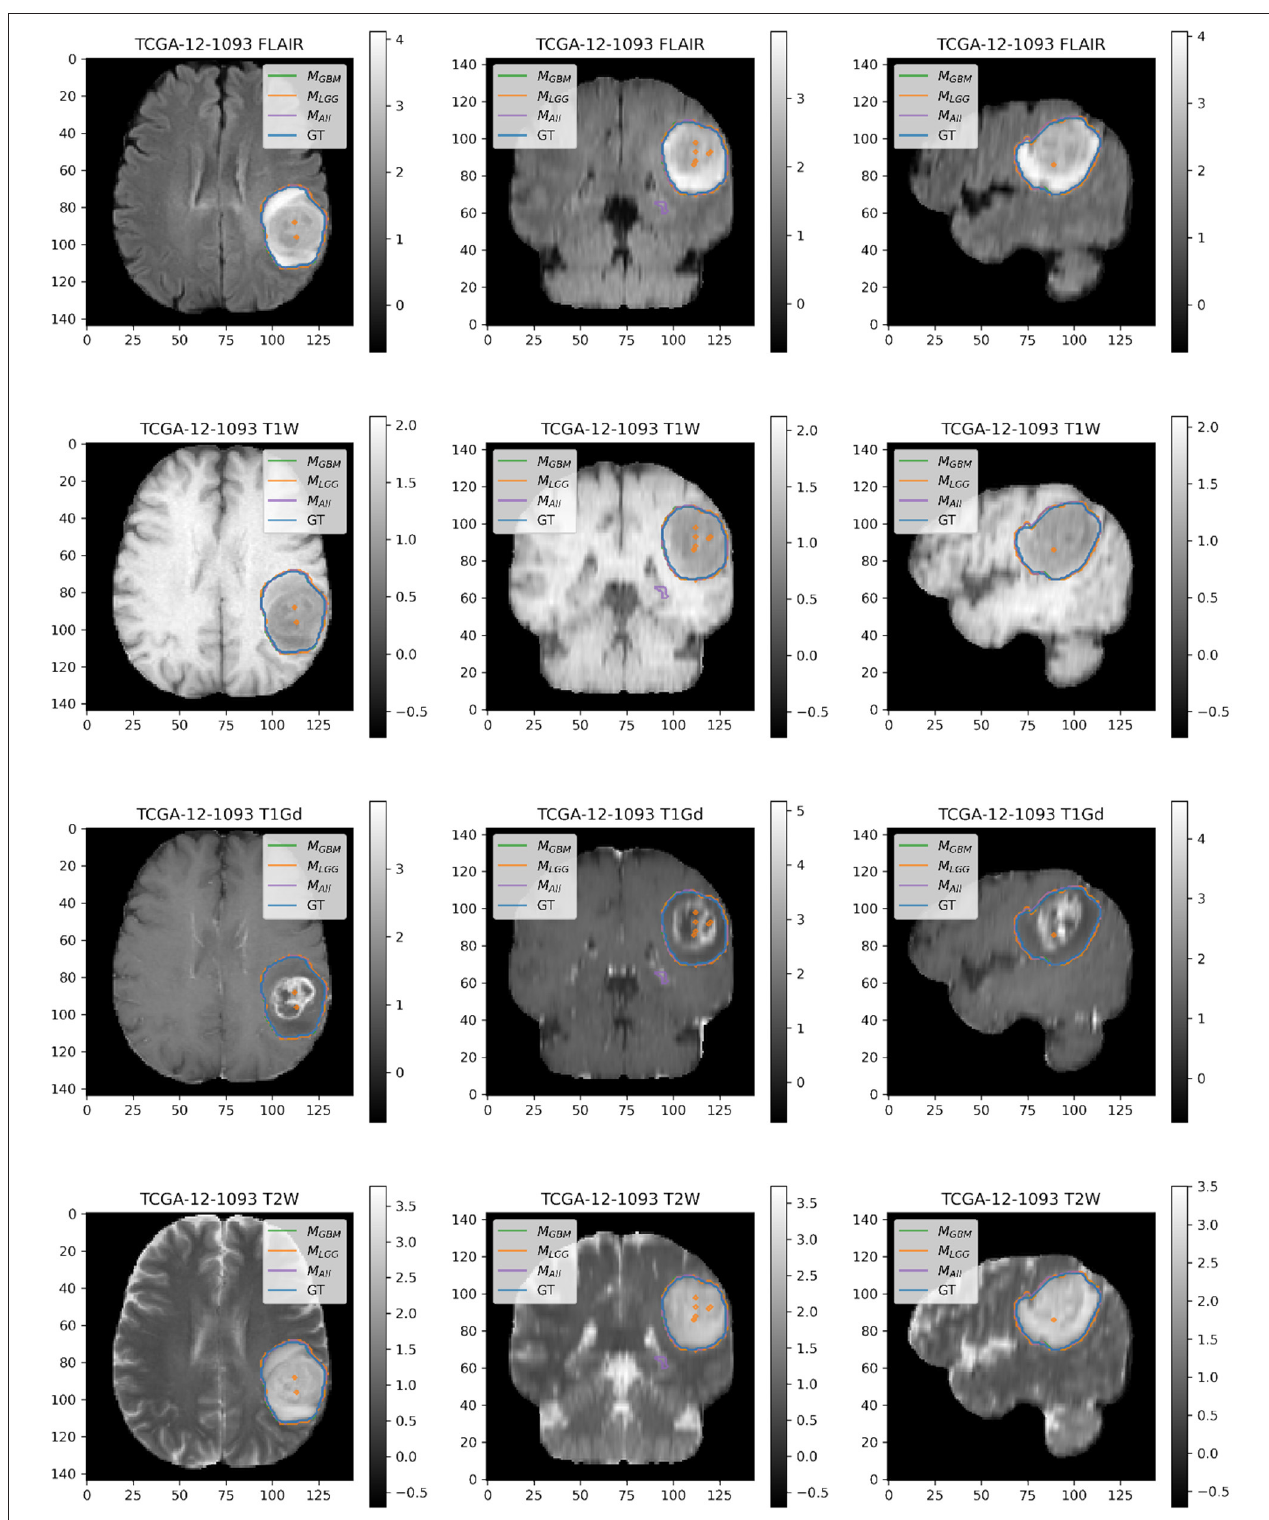
FIGURE 6 | Patient TCGA-12-1093 belongs to D GBM and has a tumor in the left parietal lobe. We selected this patient as an example because it has consistently good performance for metrics (Sens, B.Acc, Dice, Jac.C) across all models. This GBM has clear margins, and a sharp boundary on FLAIR enhancing regions. The enhancing tumor core is central and distinct, and the models all perform relatively consistently in segmentation.